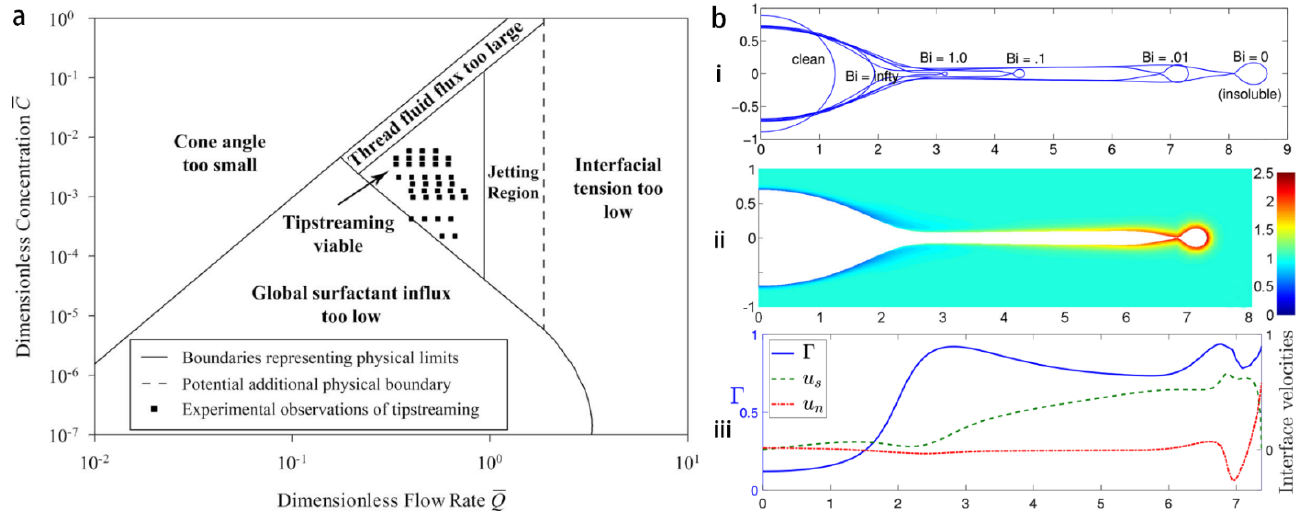
Figure 6. ( a ) Comparison between predicted operational condition of tipstreaming in planar device with the experimental data, in plane of dimensionless surfactant concentration and dimensionless flow rate of disperse fluid. The theoretical boundaries account for the interfacial mass balance of surfactants, global mass balance of fluid, geometry, transition to jetting, and minimum value of interfacial tension. Reproduced from [71], copyright 2012, AIP. ( b ) The length of the jet at first pinch for different Biot numbers ( i ), distribution of the surfactant concentration ( ii ), and an abrupt increase in surfactant concentration is observed at the interface of the jet downstream of the cone (blue line in ( iii )). Reproduced from [72], copyright 2018, American Physical Society.